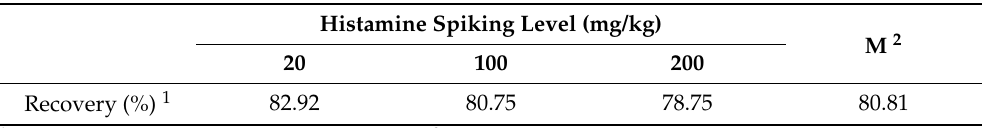
Table 2. Recovery data of the method for analysis of histamine in pet-food samples spiked at 3 concentration levels.